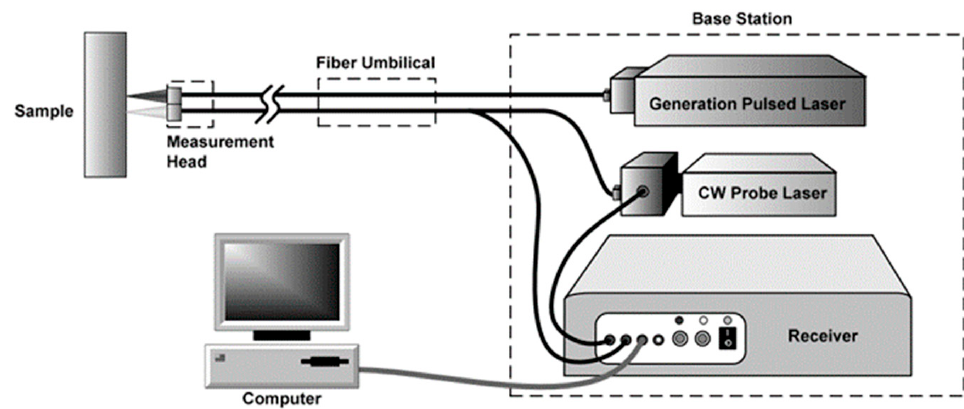
Figure 5. Laser ultrasonic inspection system [48].